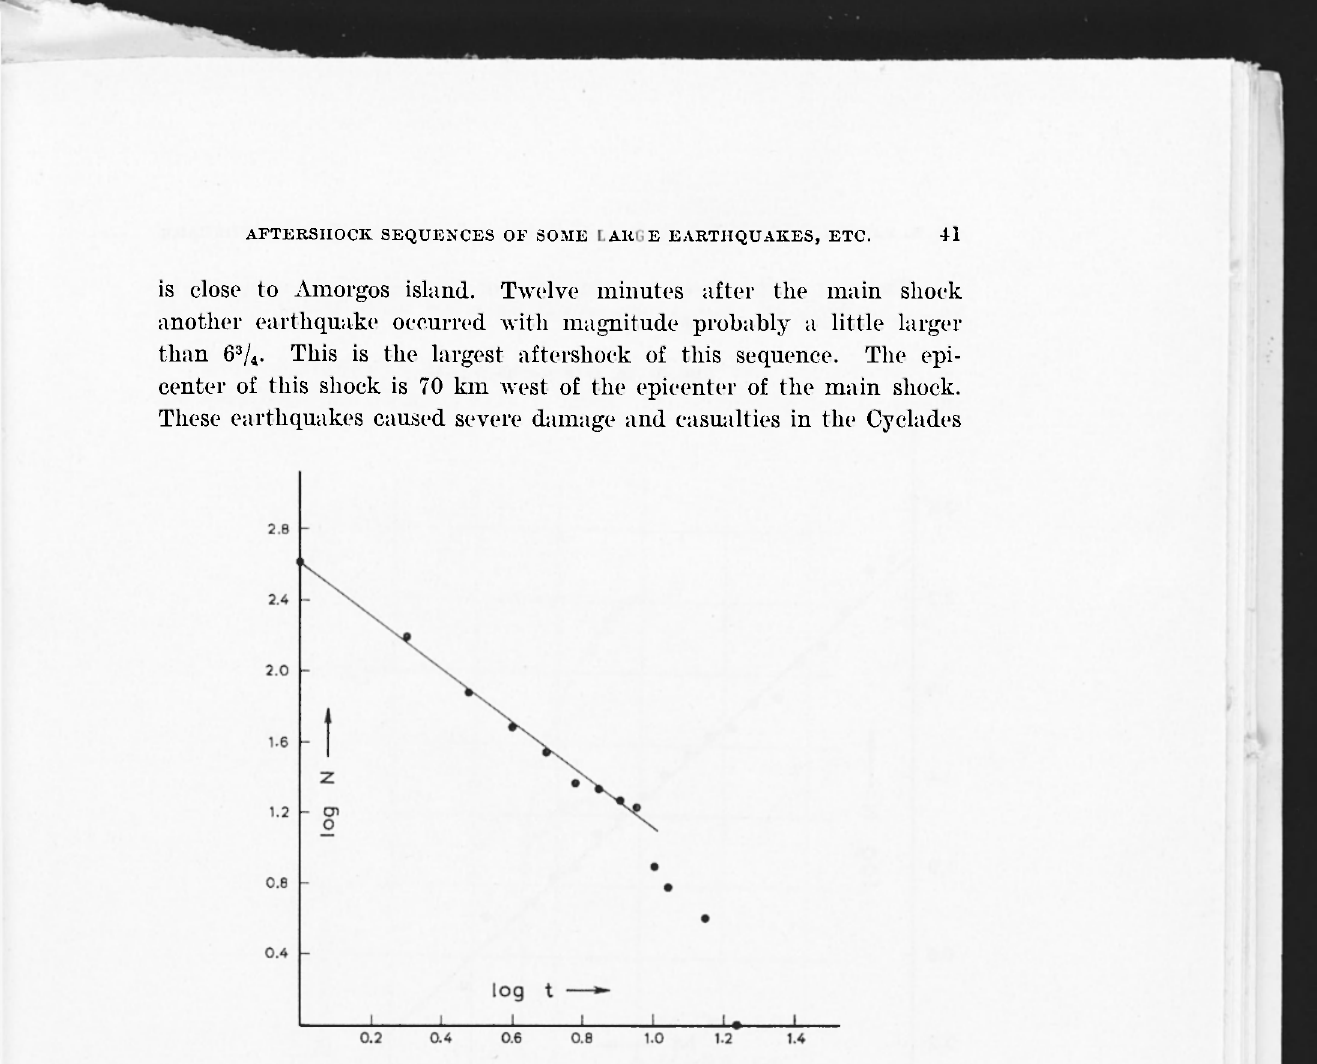
Fig. 30 - Time distribution of the aftershocks of the Amorgos Earthquake